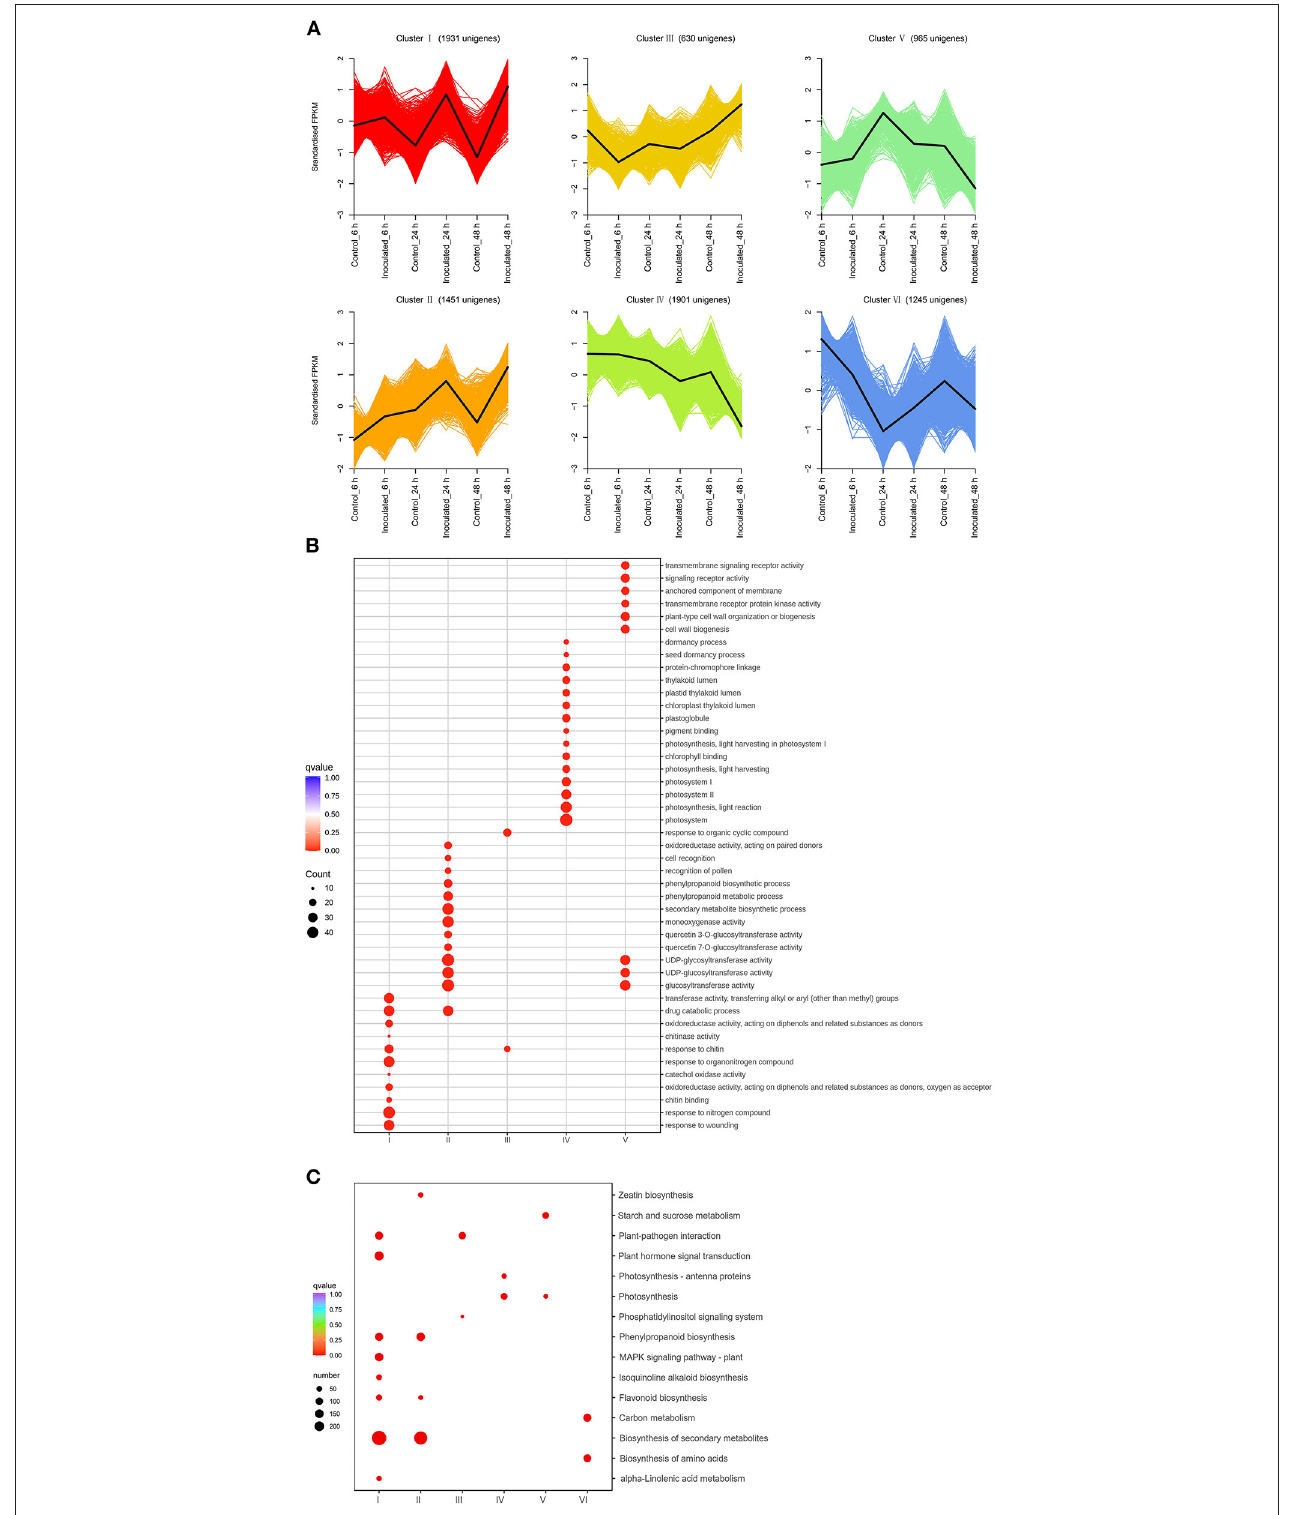
FIGURE 2 | Transcript abundance of all unigenes identified in “Sorbonne”. (A) K-means clustering analysis of differentially expressed genes (DEGs), according to their expression profiles. (B) Comparison of the gene ontology (GO) enrichment of all unigene clusters. The sizes of dots are proportional to the number of genes per GO term. Only the GO terms with more than 10 DEGs were identified; accordingly, the GO enrichment of cluster VI was eliminated. (C) Enrichment of KEGG annotations of DEGs in Lilium “ Sorbonne” with B. elliptica infection. Only the representative and significant pathways among the five clusters are shown in the figure. The size of the circle indicates the quantity, and its color corresponds to the